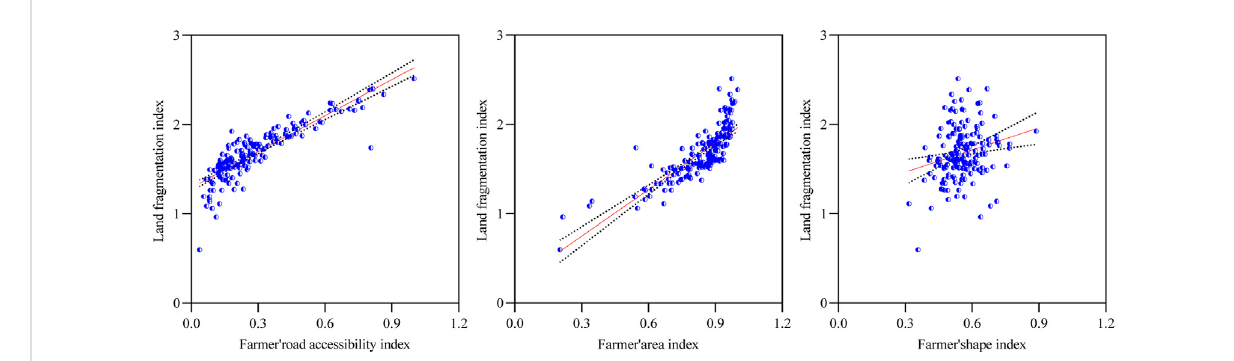
FIGURE 6 Correlation analysis on FLFI.